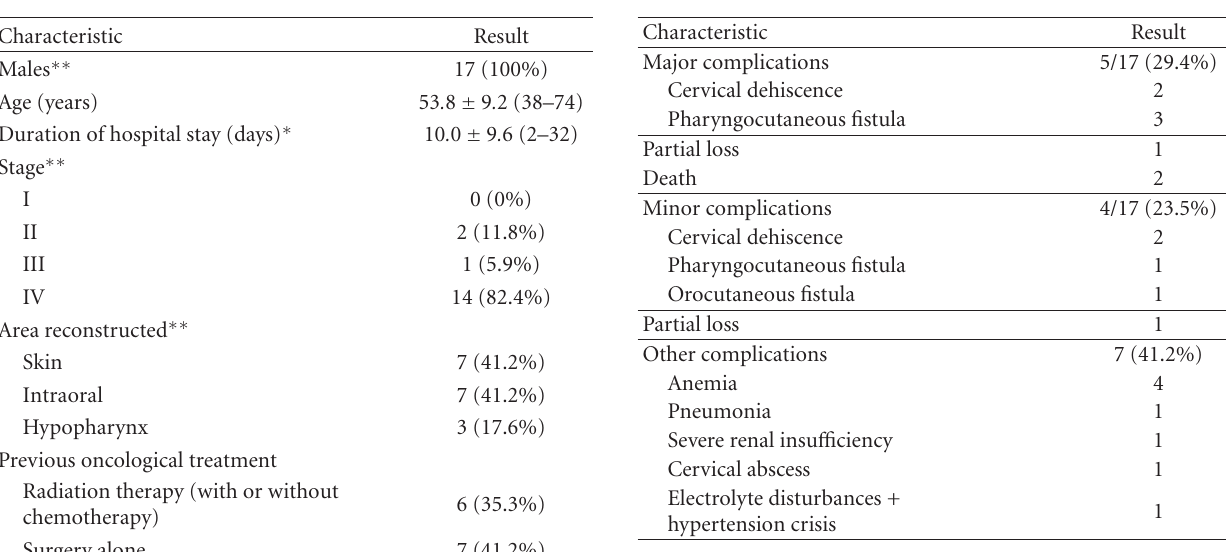
Table 1: Descriptive data. Table 2: Observed